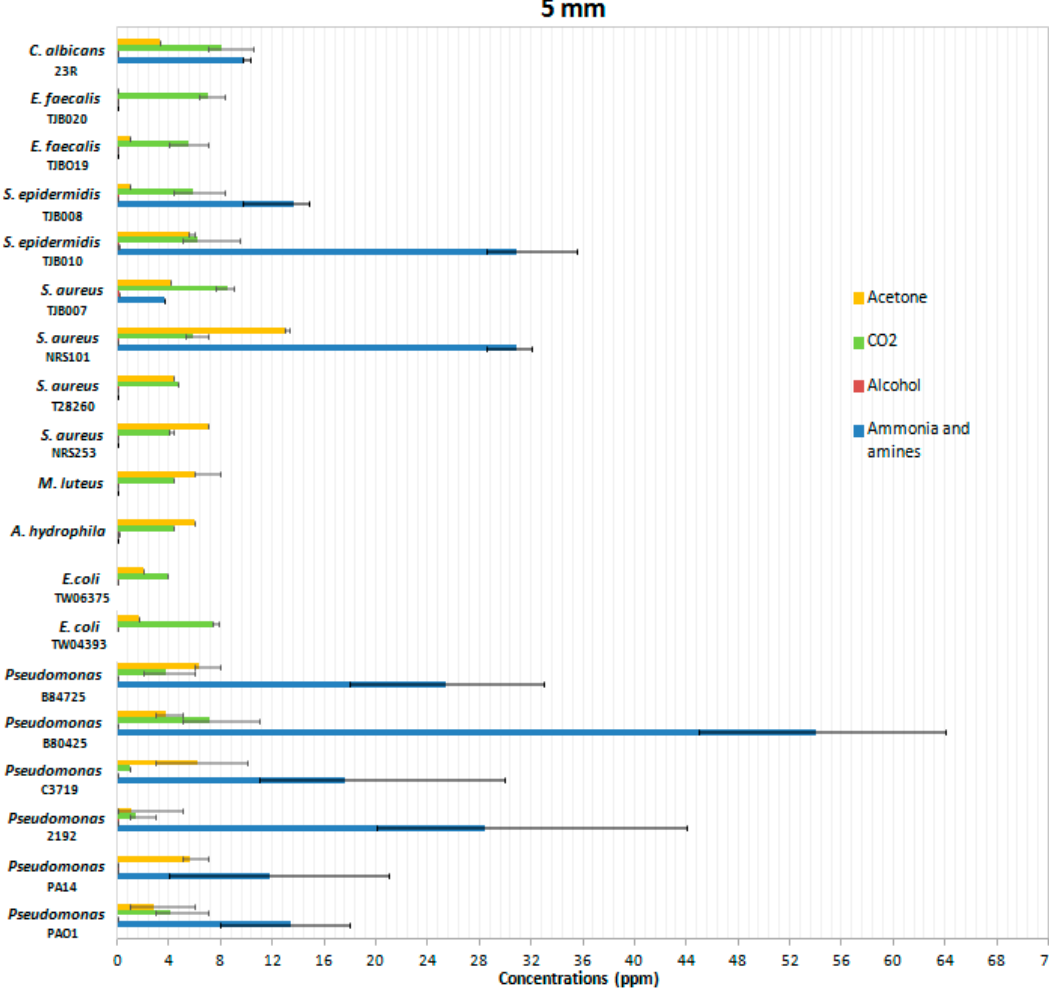
Figure 9. Mean gas concentrations produced by infectious microbial agents in solid cultures. Error bars represent one standard deviation of the data from at least three biological replicates.